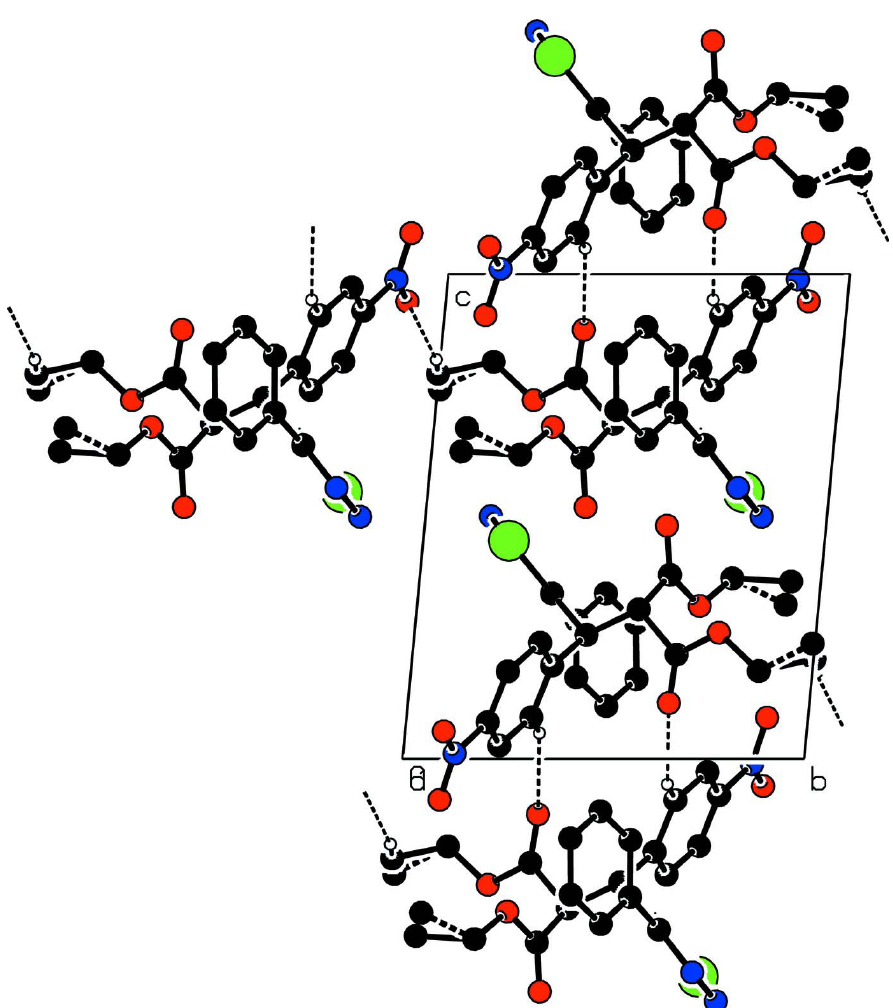
The packing of (I), viewed down the a axis. Hydrogen bonds are shown as dashed lines. H atoms not involved in hydrogen bonds have been